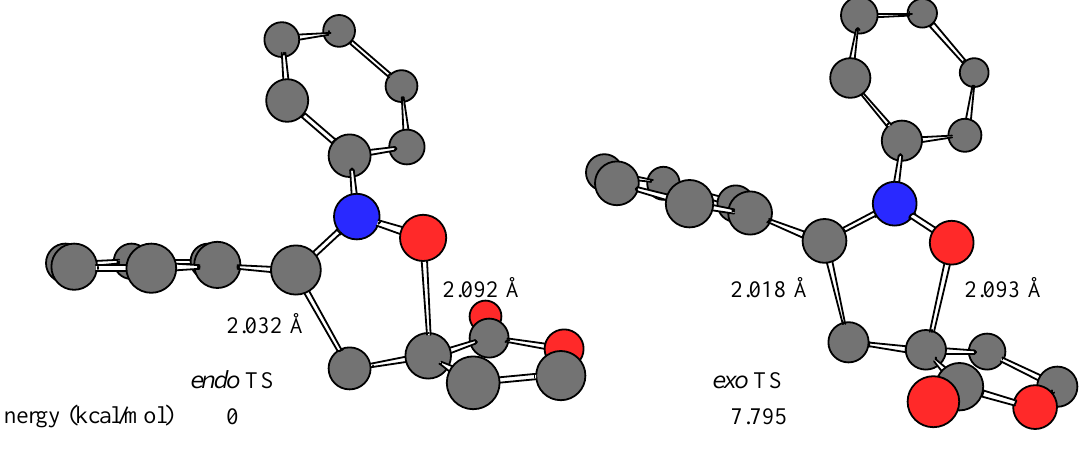
Figure 2. Calculated transition states from nitrone E - 1 (hydrogen atoms are